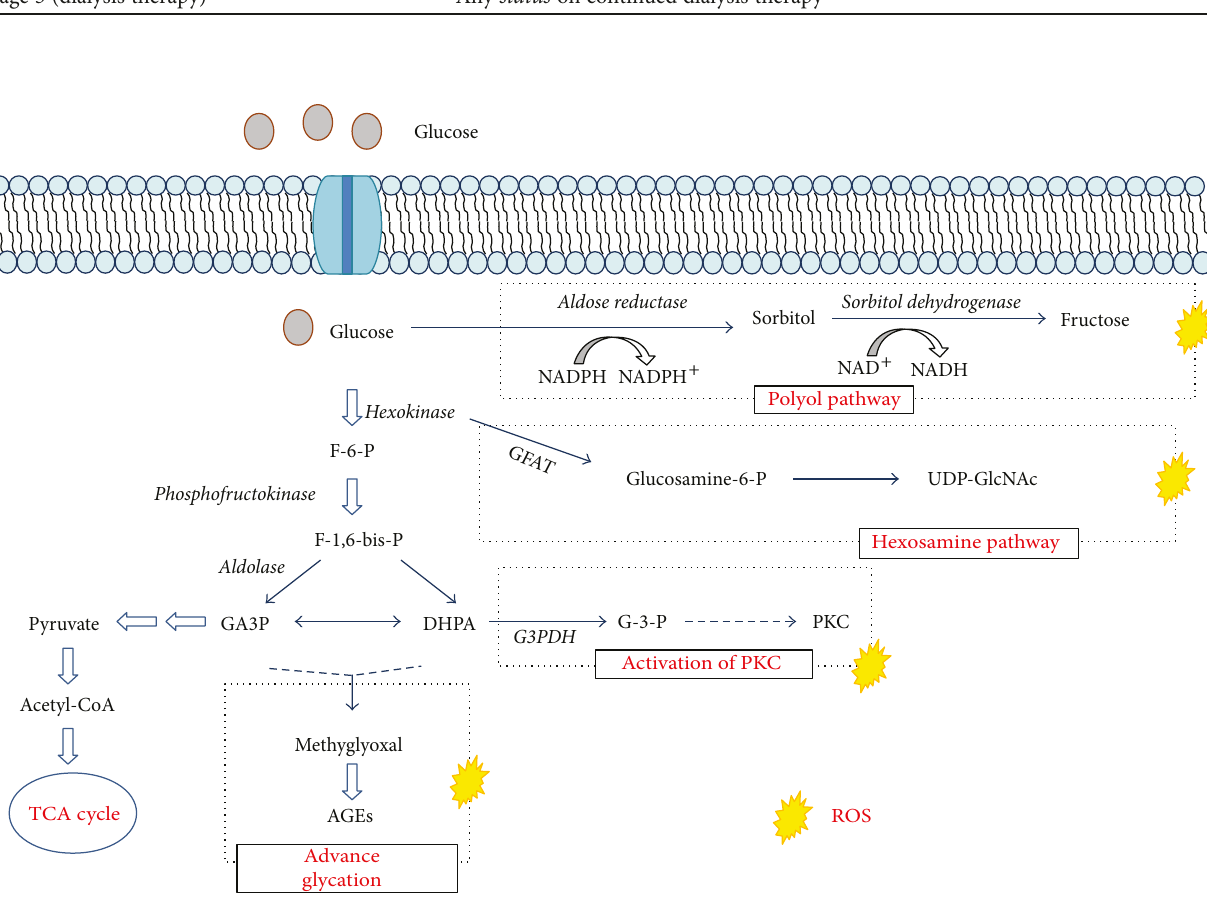
Figure 1: Mechanisms of cellular damage from the hyperglycemic state. Demonstration of the signaling pathways that are activated in the state of persistent